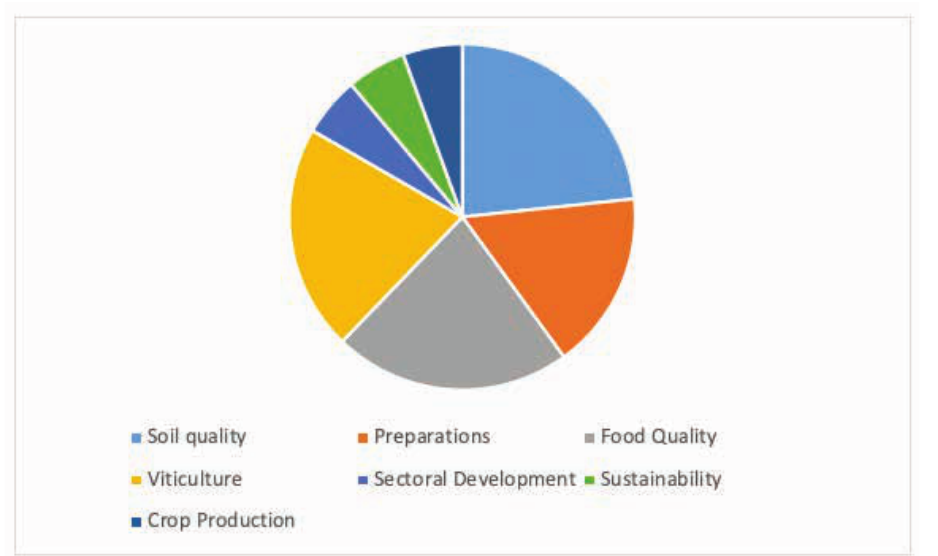
Figure 2: Thematic distribution of peer-reviewed publications in biodynamic food and farming. Note: Single articles appear in all thematic clusters they